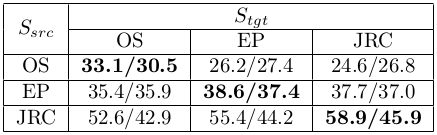
Table from the paper: Monolingual and Cross-lingual Zero-shot Style Transfer
Table text:
S src
S tgt
OS
EP
JRC
OS
33.1/30.5
26.2/27.4
24.6/26.8
EP
35.4/35.9
38.6/37.4
37.7/37.0
JRC
52.6/42.9
55.4/44.2
58.9/45.9